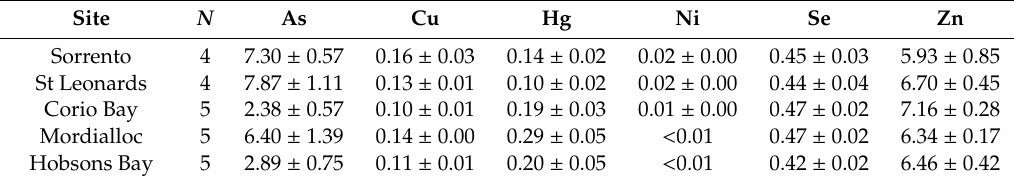
Table 1. Trace elements (mg / kg) found in the flesh of sand flathead collected from Port Phillip Bay in February / March 2015. Results are presented as the mean of the composite pools for each site ( ± SEM, where possible). Note: Cadmium, chromium, silver, and lead were below the detection limit (0.01, 0.05, 0.02, and 0.01 mg / kg, respectively). No Polycyclic Aromatic Hydrocarbons (PAHs), Organochlorine (OC) pesticides, or Polychlorinated Biphenyls (PCBs) were detectable in any of the samples of sand flathead white muscle collected throughout Port Phillip Bay (adapted from Gagnon et al. [21]).